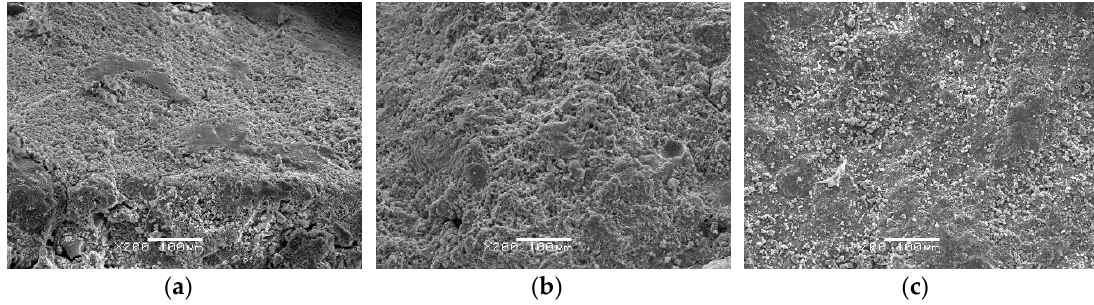
Figure 20. Microscopic appearance of mortar: ( a ) w/c ratio: 0.68; ( b ) w/c ratio: 0.54; ( c ) w/c ratio: 0.44.